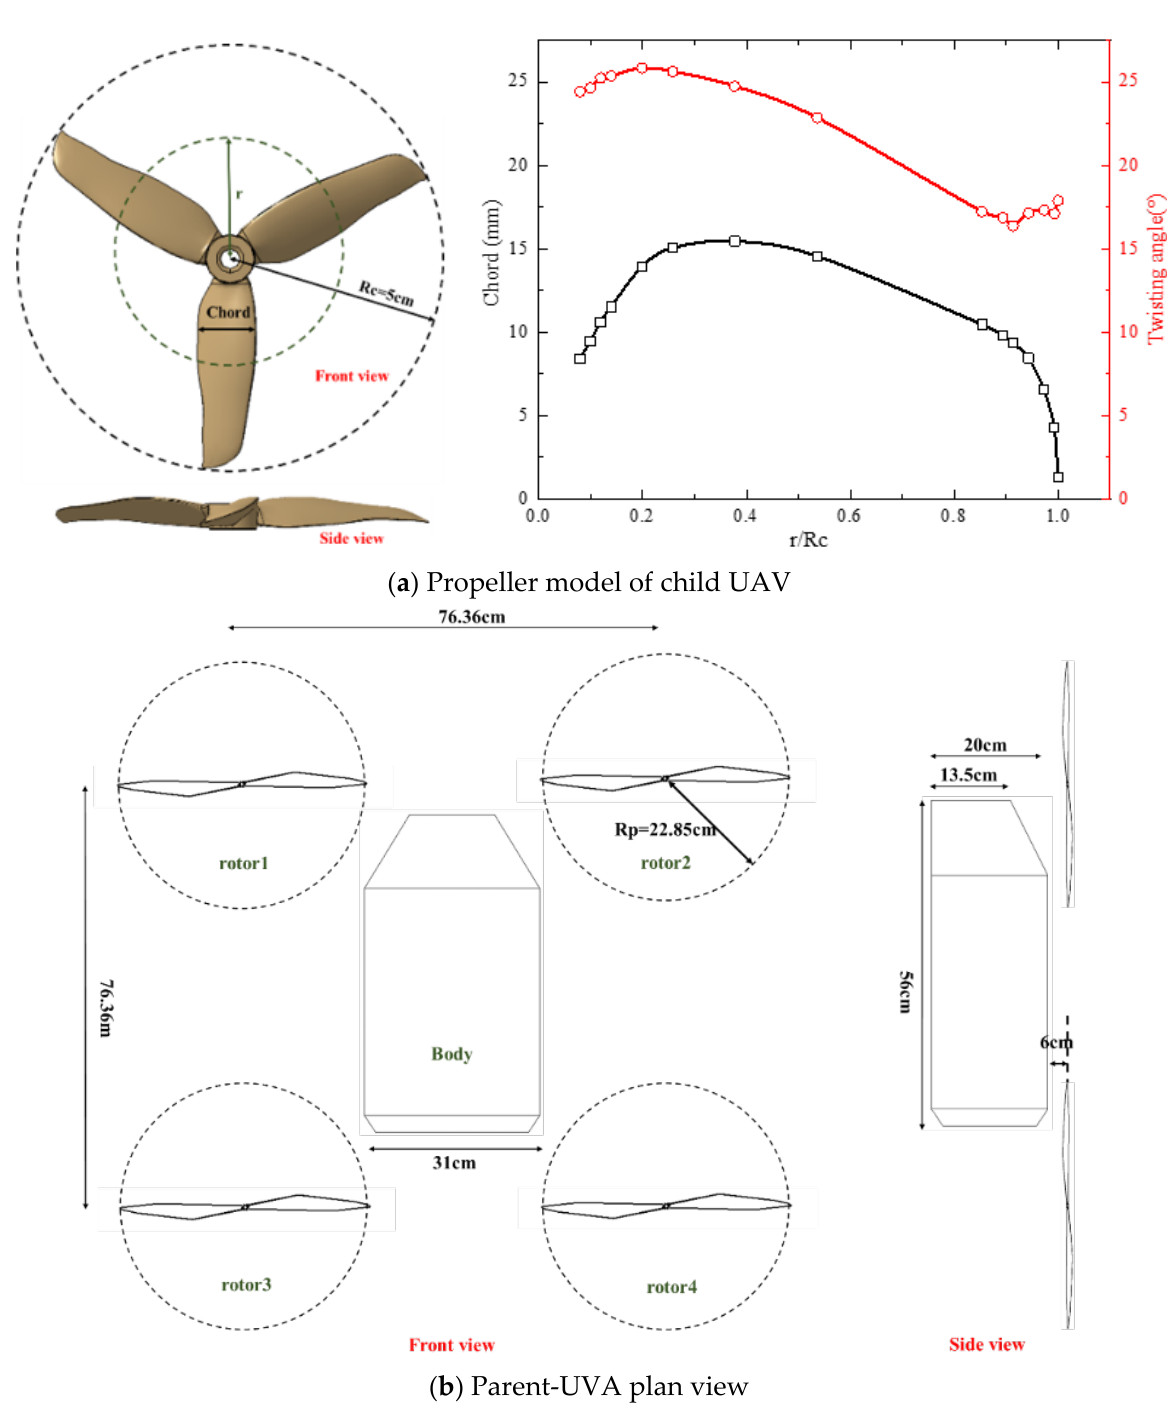
Figure 2. Research model and